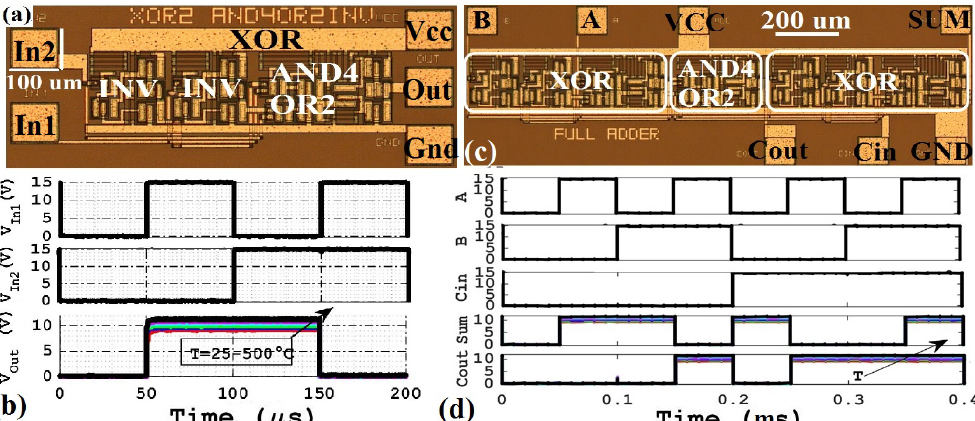
Figure 16. SiC TTL-based XOR and full-adder ( a ) XOR micro-photograph ( b ) XOR measured transient-response in the range of 25–500 ○ C by applying f in 1 = 10 kHz f in 2 = 5 kHz with V IH = 15 V and V IL = 0 V. ( c ) Full-adder micro-photograph ( d ) Full-adder measured transient-response in the range of 25 to 500 ○ C by applying f in 1 = 10 kHz at A f in 2 = 5 kHz at and f in 3 = 2.5 kHz at Cin with V IH = 15 V and V IL = 0